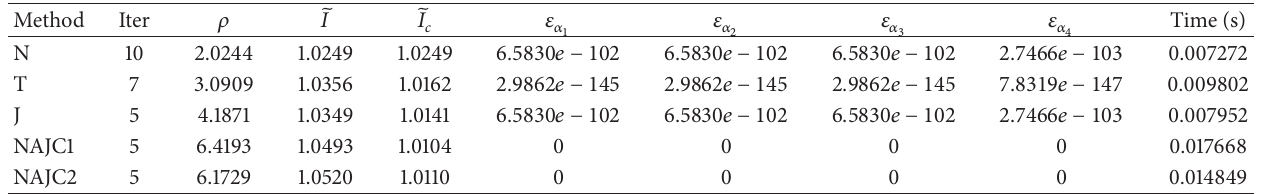
Table 7: Results of system (c), 𝑥 (0) = (5,5, 5,−1) 𝑇